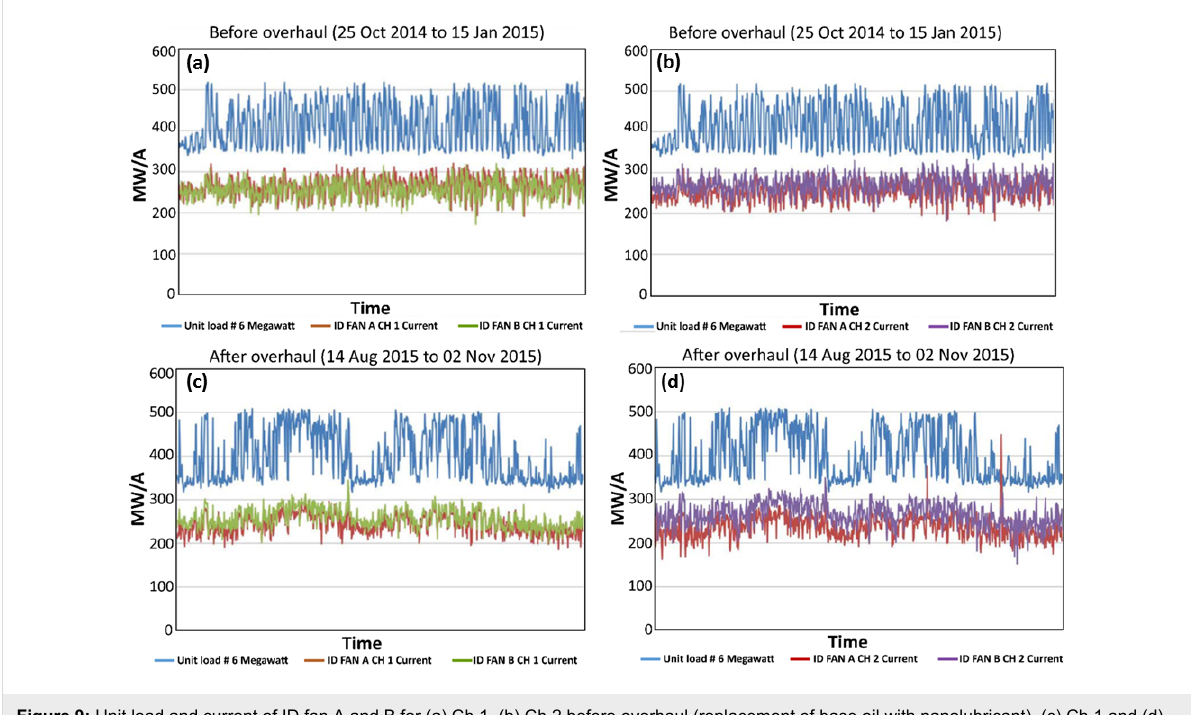
Figure 9: Unit load and current of ID fan A and B for (a) Ch 1, (b) Ch 2 before overhaul (replacement of base oil with nanolubricant), (c) Ch 1 and (d) Ch 2 after overhaul.